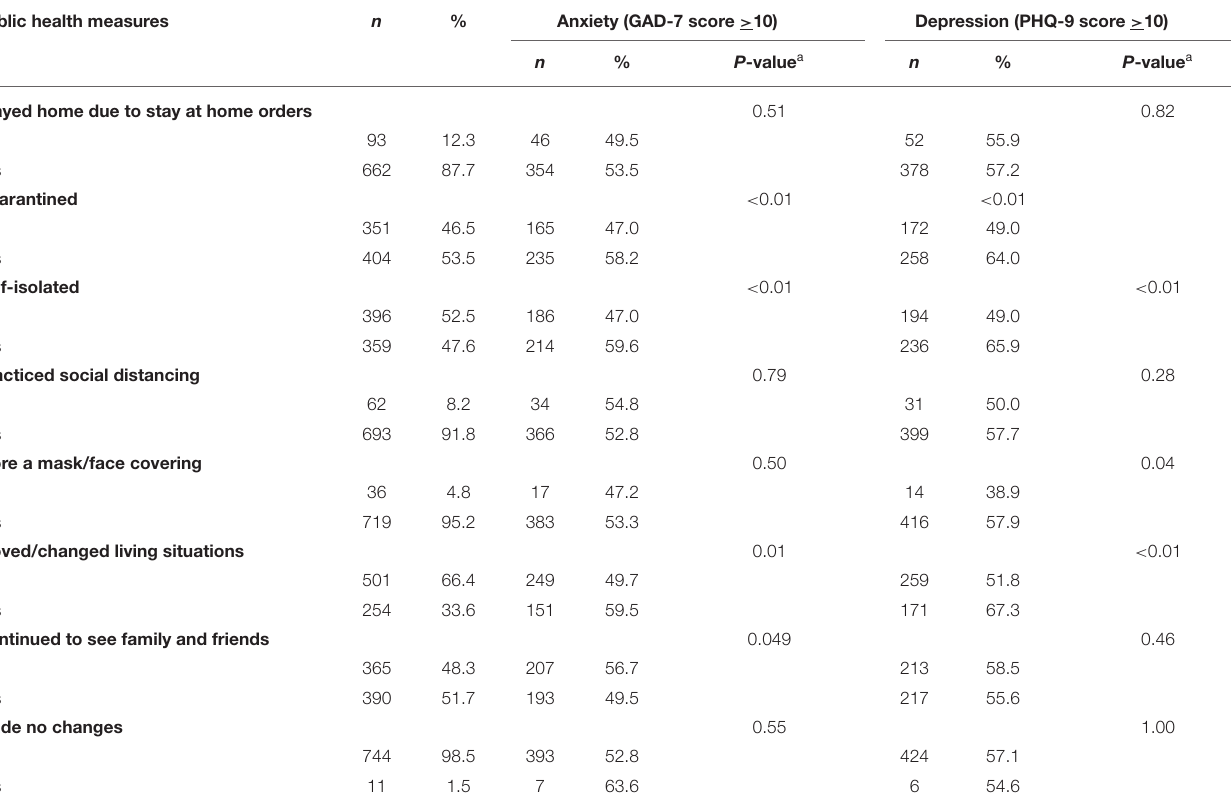
TABLE 2 | Practicing public health measures and prevalence of anxiety and depression.